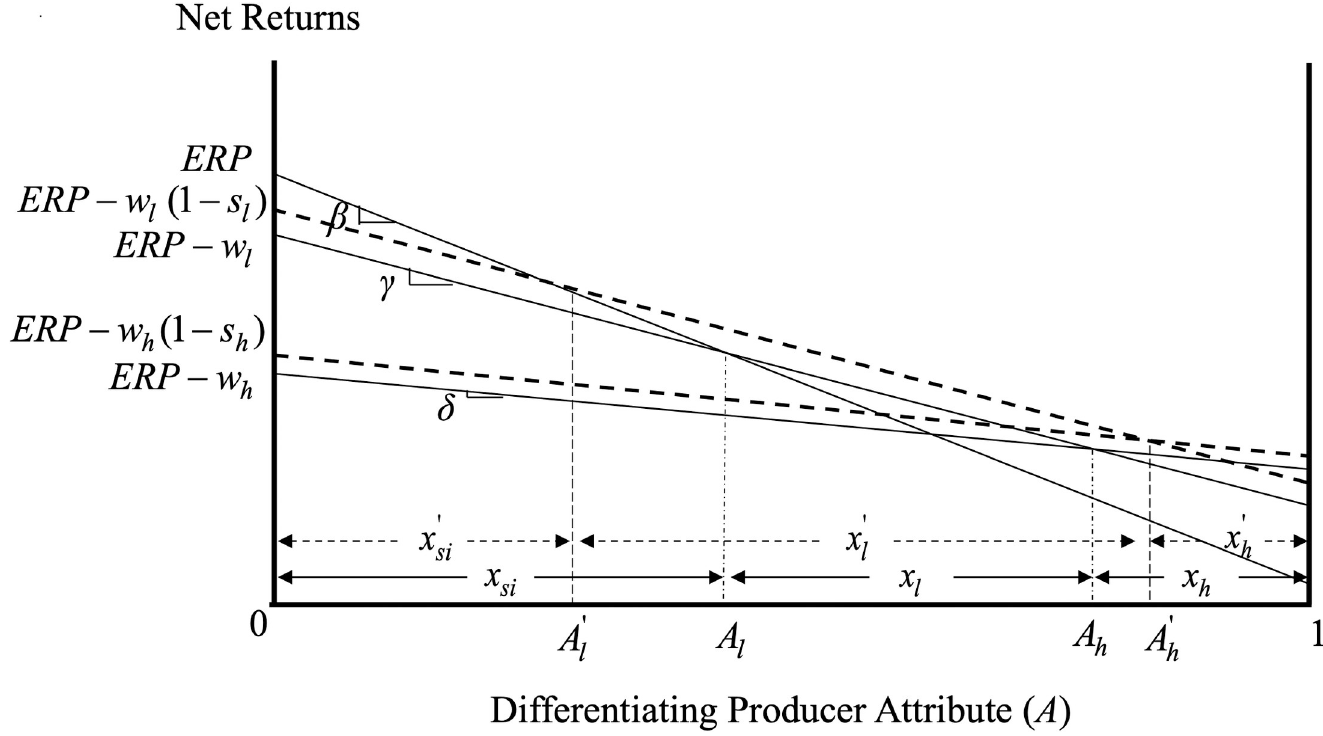
Fig 3. Market and welfare effects of premium subsidies when s l w l < s h w h .